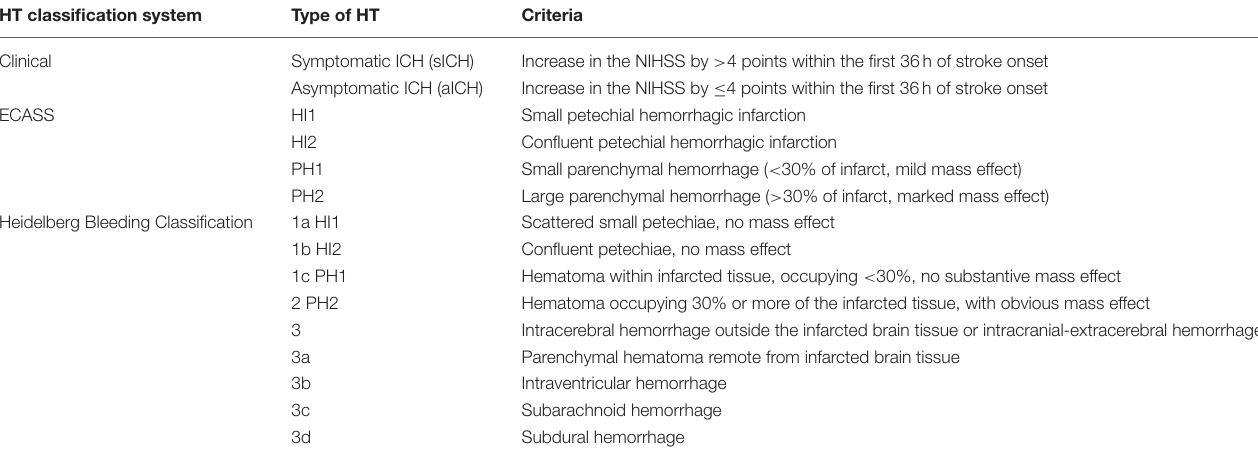
TABLE 1 | Classification systems of HT in ischemic